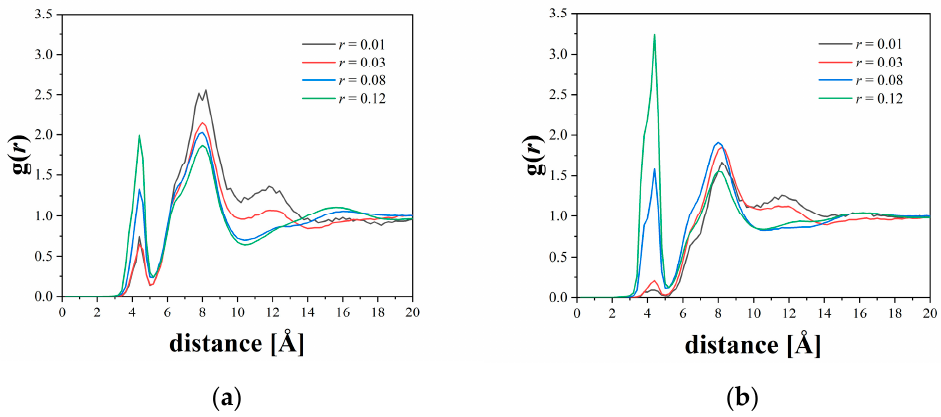
Figure 4. Radial distribution function between Li ions and N atoms of TFSI ions at various salt concentrations for ( a ) PEO and ( b ) P(2EO-MO).